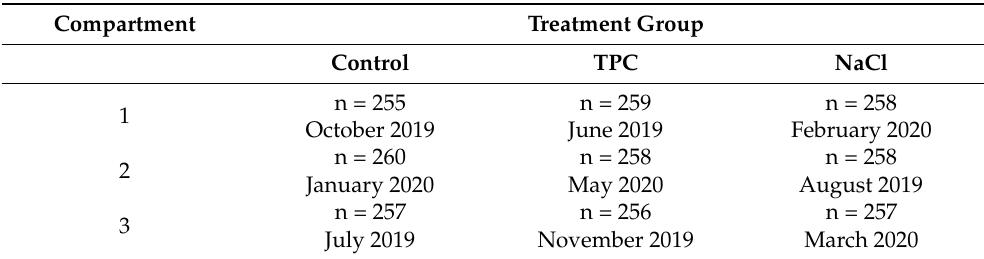
Table 1. Number of animals and month of placement of the three treatment groups in the three compartments. There were three batches (replicates) of each treatment, and each batch of treatments was housed in a different compartment. The control group (control) received the normal feed used on the farm, and the tripotassium citrate (TPC) and the sodium chloride (NaCl) groups received the normal feed that was supplemented with 0.25% TPC and 0.20% NaCl, respectively. Compartment Treatment Group Control TPC NaCl n = 1